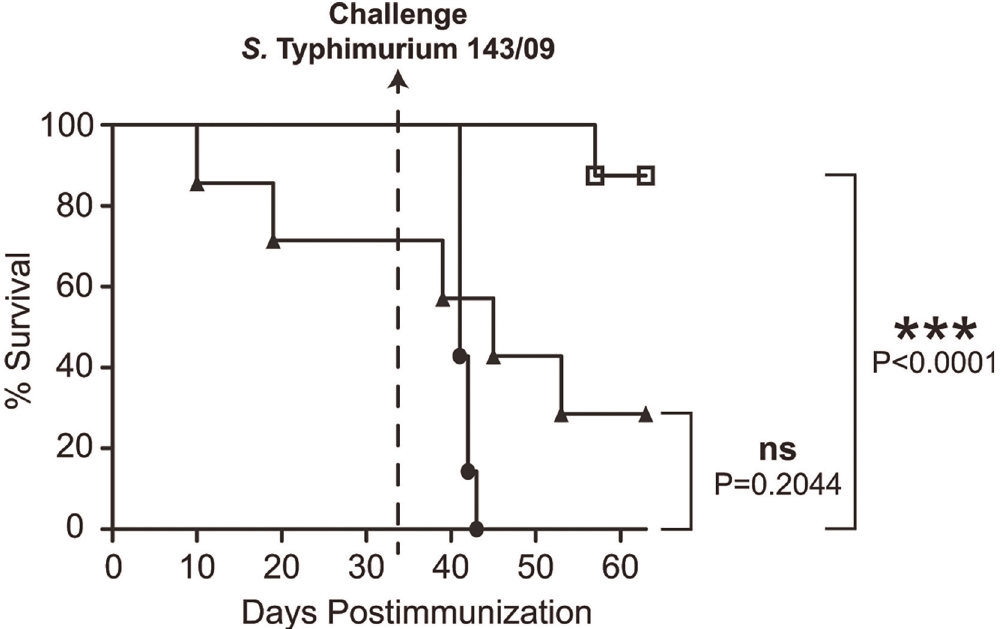
Fig 3. Vaccination-challenge analysis of the protection conferred by Δ XIII. Groups of seven BALBc mice were orally vaccinated with 10 7 cfu of Δ XIII (open squares), Δ rpoS (black triangles) or PBS as a control (black circles). 33 days post immunization, mice were challenged with 10 6 cfu/mouse of S . Typhimurium 143/09. Survival curves were plotted and P-values were determined by a Log-rank (Mantel-Cox)